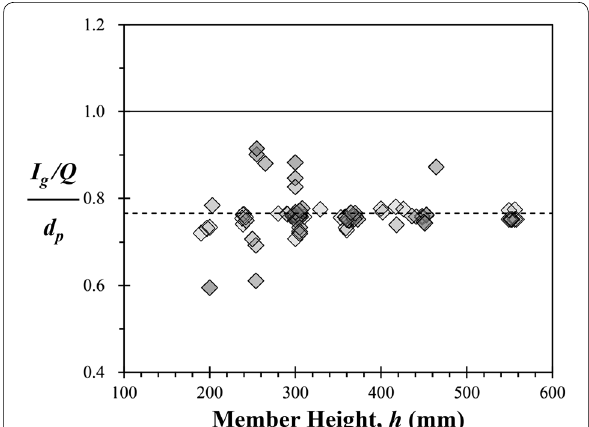
Fig. 13 Ratio of average to parabolic shear stress.